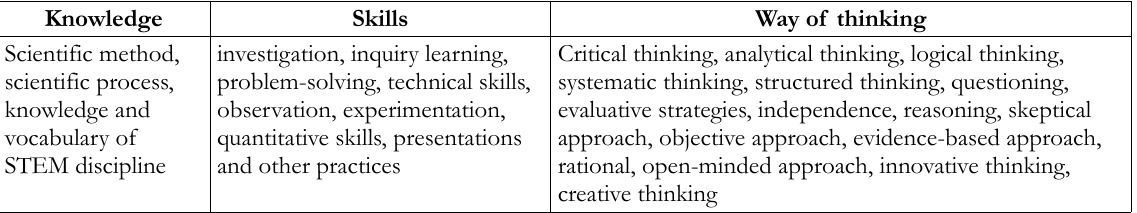
Table 1. The STEM capabilities (West,